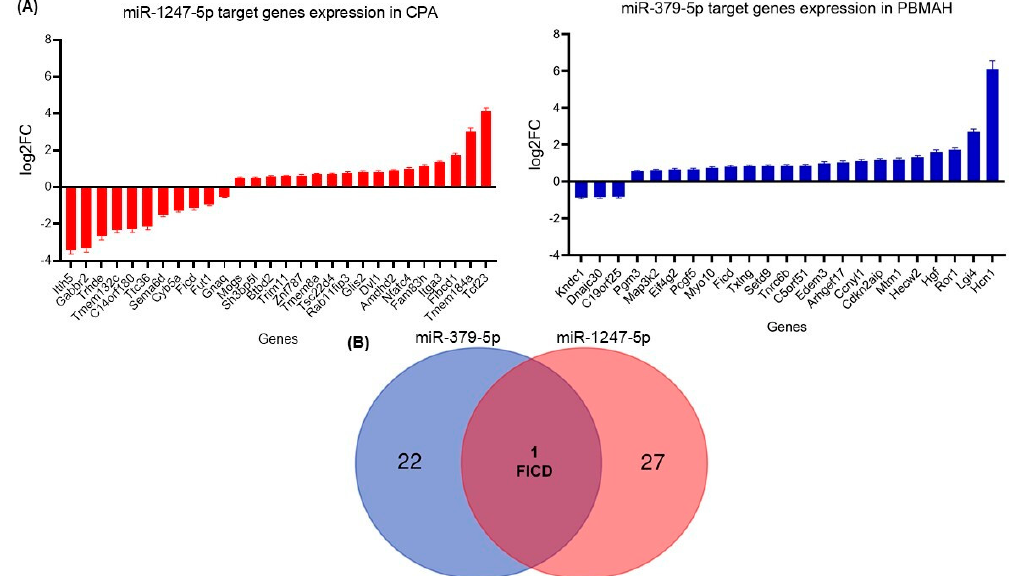
Figure 6. ( A ) Differentially expressed target genes of miRNAs from sequencing. Data are represented as log2 fold change in comparison to the controls. Statistics: ANOVA test with Bonferroni correction to detect significant differences between patient groups with at least a significance of p -value < 0.05. ( B ) Venn analyses of common significant miRNA target genes and related pathways. The significantly expressed targets from each sequencing analysis were shortlisted and compared between the groups. Predicted pathways of the targets from the Panther database were shortlisted and compared between the groups.